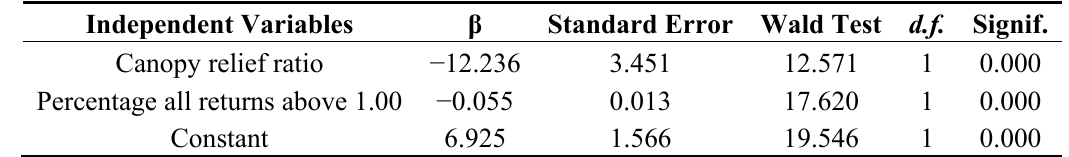
Table 8. β coefficients, Walt test values, degrees of freedom ( d.f .) and their significance p ≤ 0.05 computed for the variables of the selected regression model.